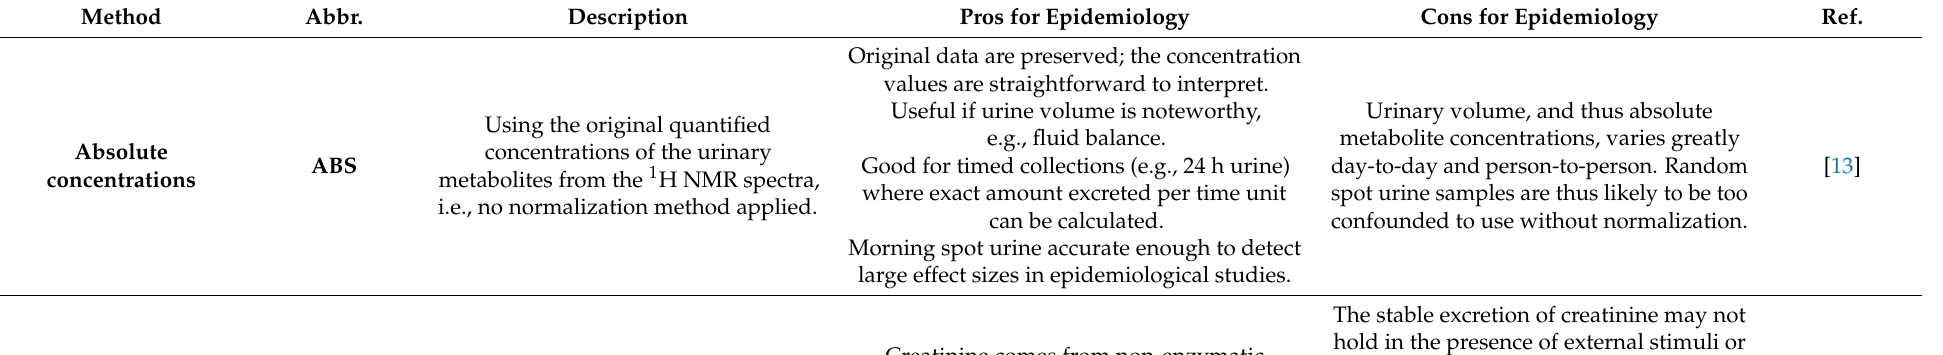
Table 1. The characteristics of employed normalization